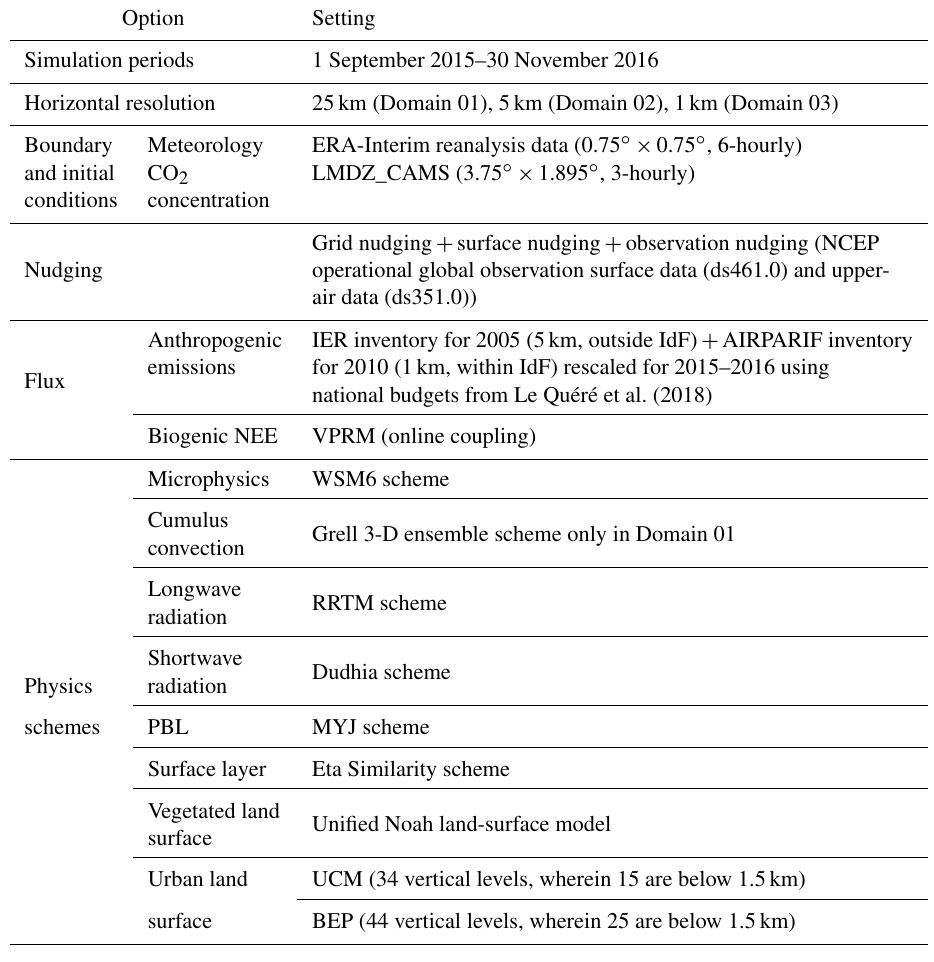
Table 2. A summary of WRF-Chem configurations used in this